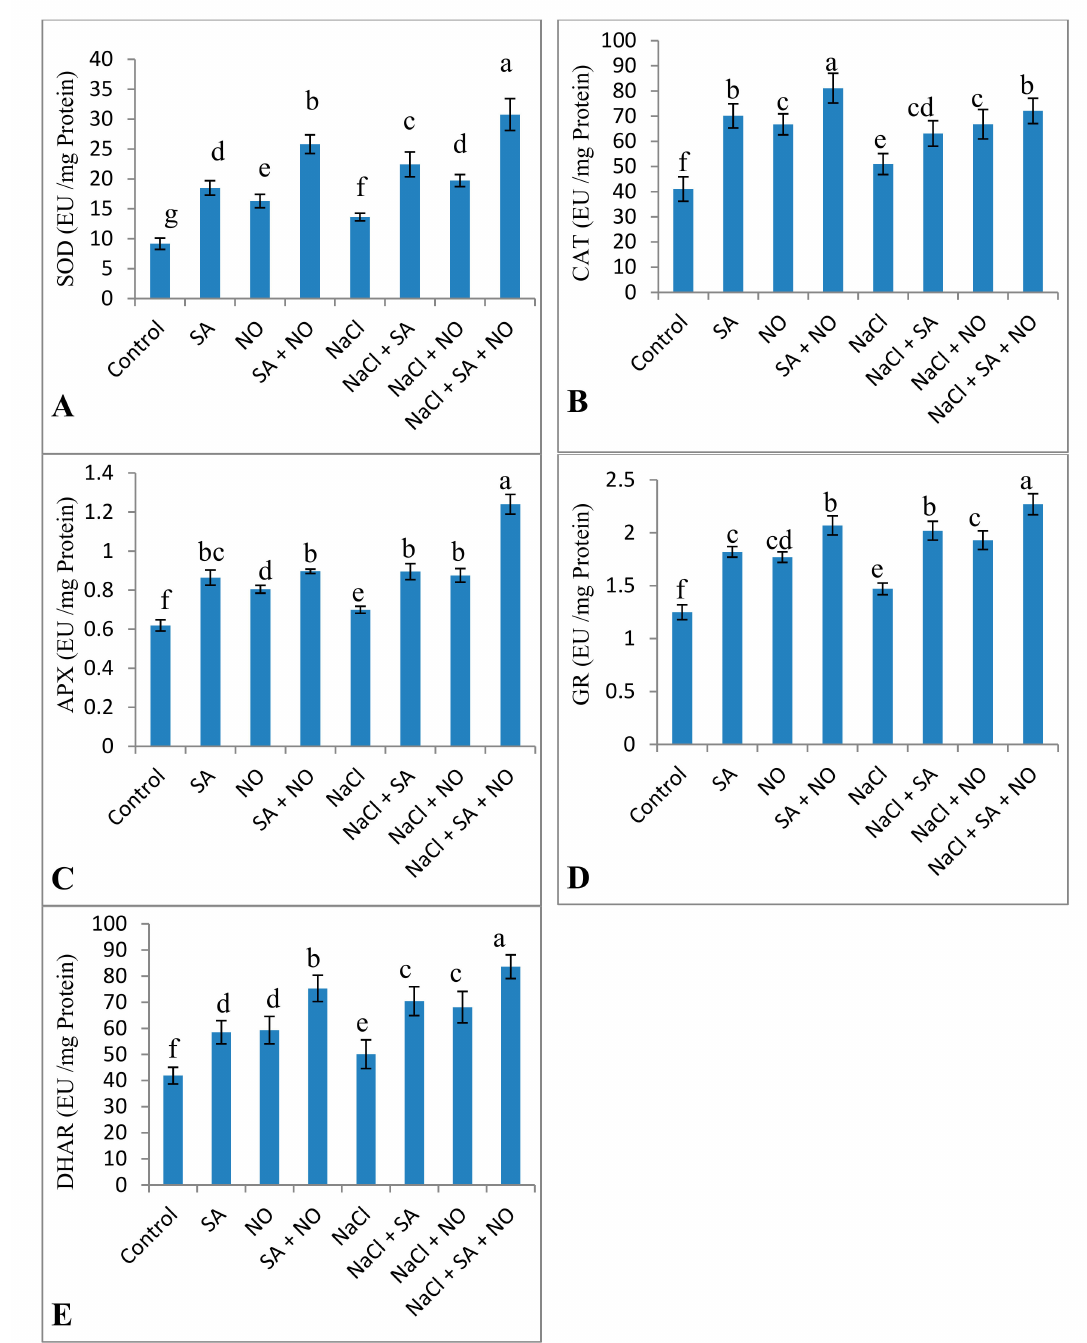
Figure 5. E ff ect of exogenous application of SA and NO on activity of ( A ) superoxide dismutase (SOD), ( B ) catalase (CAT), ( C ) ascorbate peroxidase (APX), ( D ) glutathione reductase (GR) and ( E ) DHAR in Vigna angularis under salinity (100 mM NaCl) stress. Data are the mean of four replicates and di ff erent letters show significant di ff erence at p <